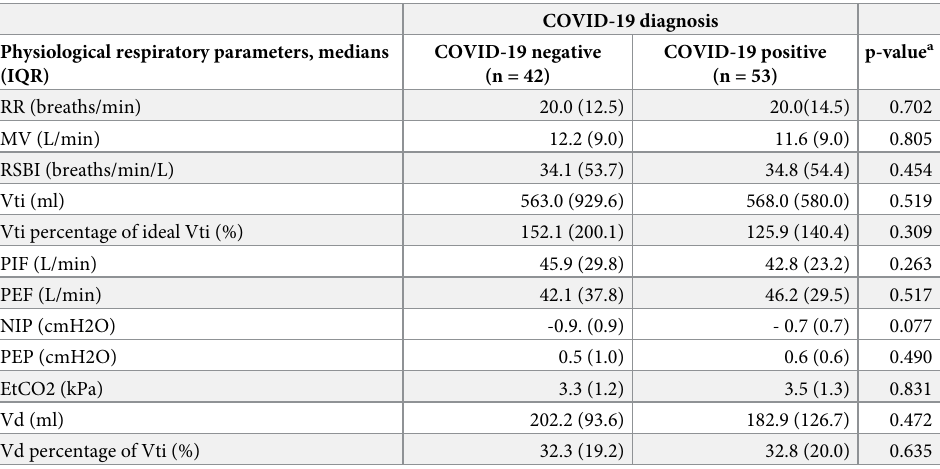
Table 3. Physiological respiratory parameters and